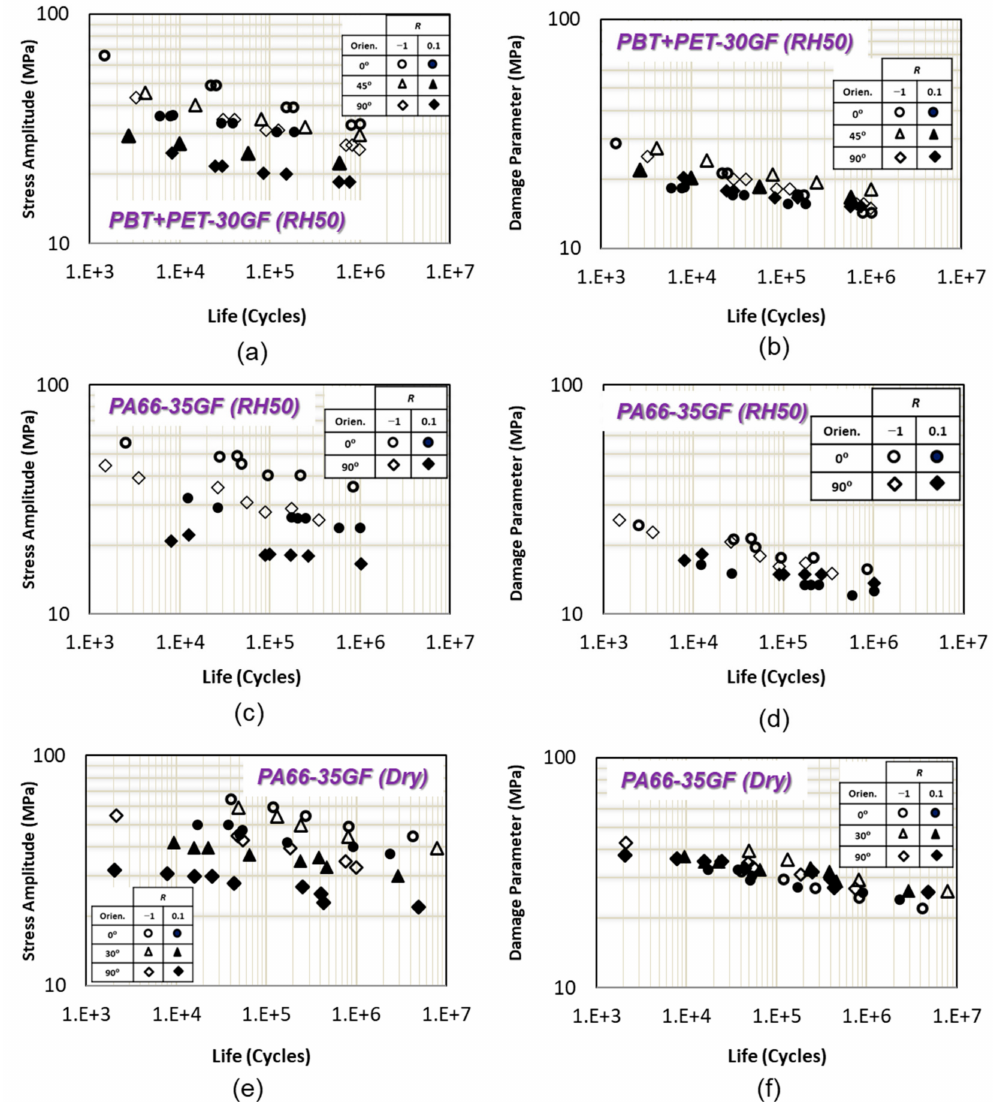
Figure 6. ( a ) Uniaxial fatigue data of PBT + PET-30GF from [9]. ( b ) Uniaxial fatigue data correlations of PBT + PET-30GF using the proposed damage parameter. ( c ) Uniaxial fatigue data of PA66-35GF with 50% relative humidity from [17]. ( d ) Uniaxial fatigue data correlations of PA66-35GF with 50% relative humidity with the proposed damage parameter. ( e ) Uniaxial fatigue data of PA66-35GF with dry condition from [18]. ( f ) Uniaxial fatigue data correlations of PA66-35GF with dry condition with the proposed damage